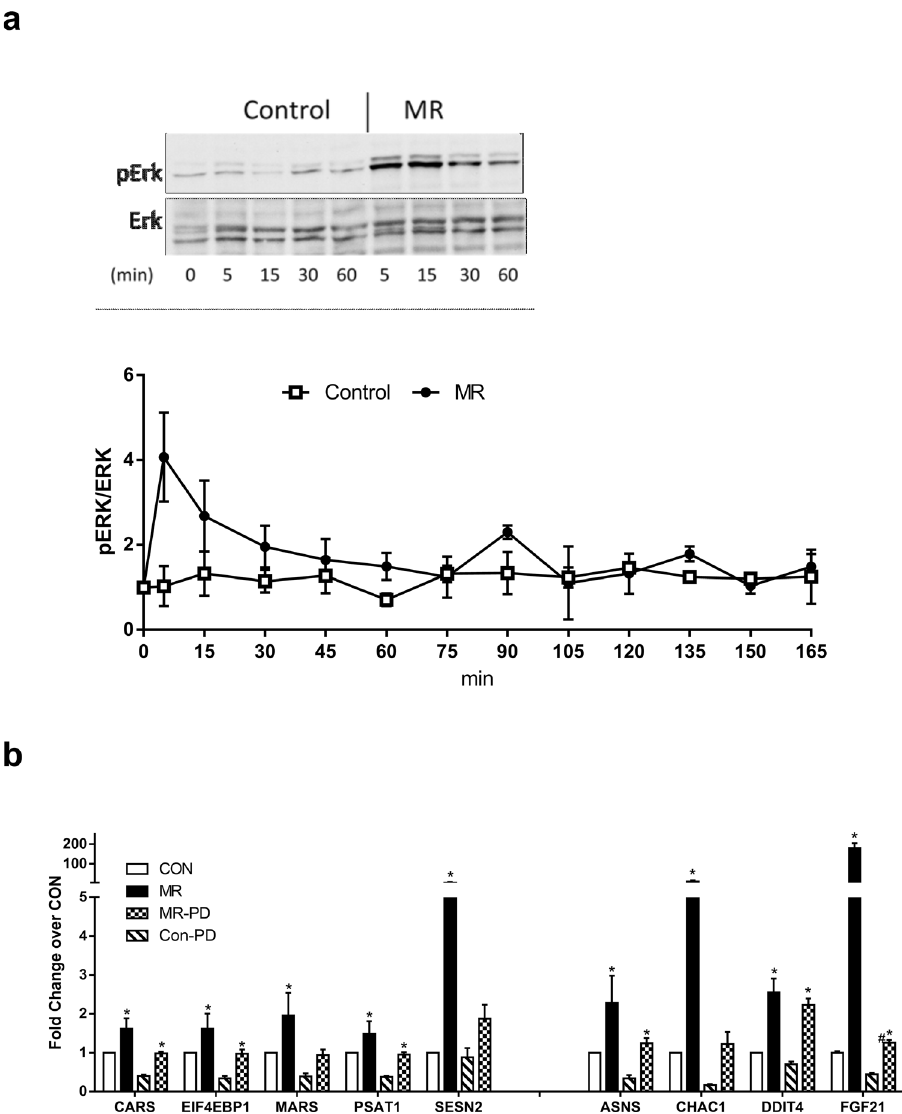
Figure 5. ( a ) HepG2 cells were exposed to either Con or MR media for 165 min and samples were taken after 5 min, and thereafter in 15 min intervals. Western blot analysis shows a representative detection of pErk and Erk up to 60 min exposure. Images are cropped, the full-length blot is presented in Supplementary Figure S2. The graph shows the average of pErk/Erk densitometric ratios from 5 independent experiments. ( b ) HepG2 cells were treated with Erk inhibitor PD98059 (50 µM) or vehicle and gene expression was measured after cultivation for 6 h in either Con or MR media. Data for HepG2 cells were obtained from at least two independent experiments with duplicates and fold induction was averaged. Data were compared between Con and MR for each gene using t-test and are presented as fold induction from Con. * Con different from MR; # MR without different from MR with PD98059; p <